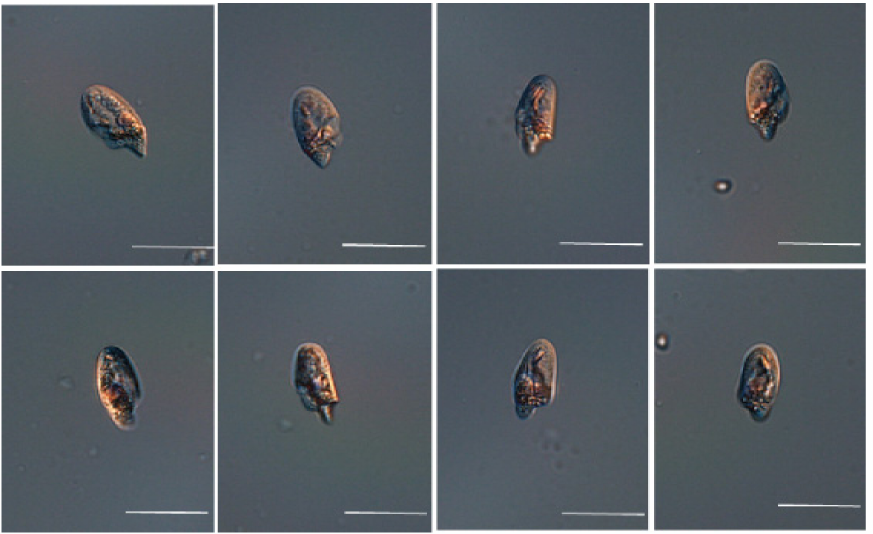
Figure 3. Micrographs of Oxyrrhis maritima (OMJJ 305) using light microscopy. Scale bars = 20 µ m. The length and width of living cells of O. maritima starved for 5 d (n = 30) ranged 14.4–28.0 µ m (mean + SD = 20.6 ± 3.3 µ m) and 9.6–15.2 µ m (11.8 ± 1.9 µ m),